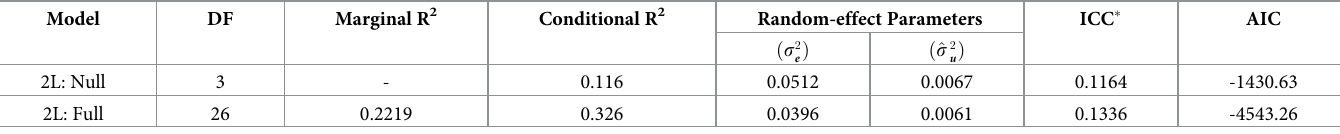
Table 1. Summary statistics of the fitted 2-level (2L) linear mixed-effects model (BHF model) using REML method of estimation.